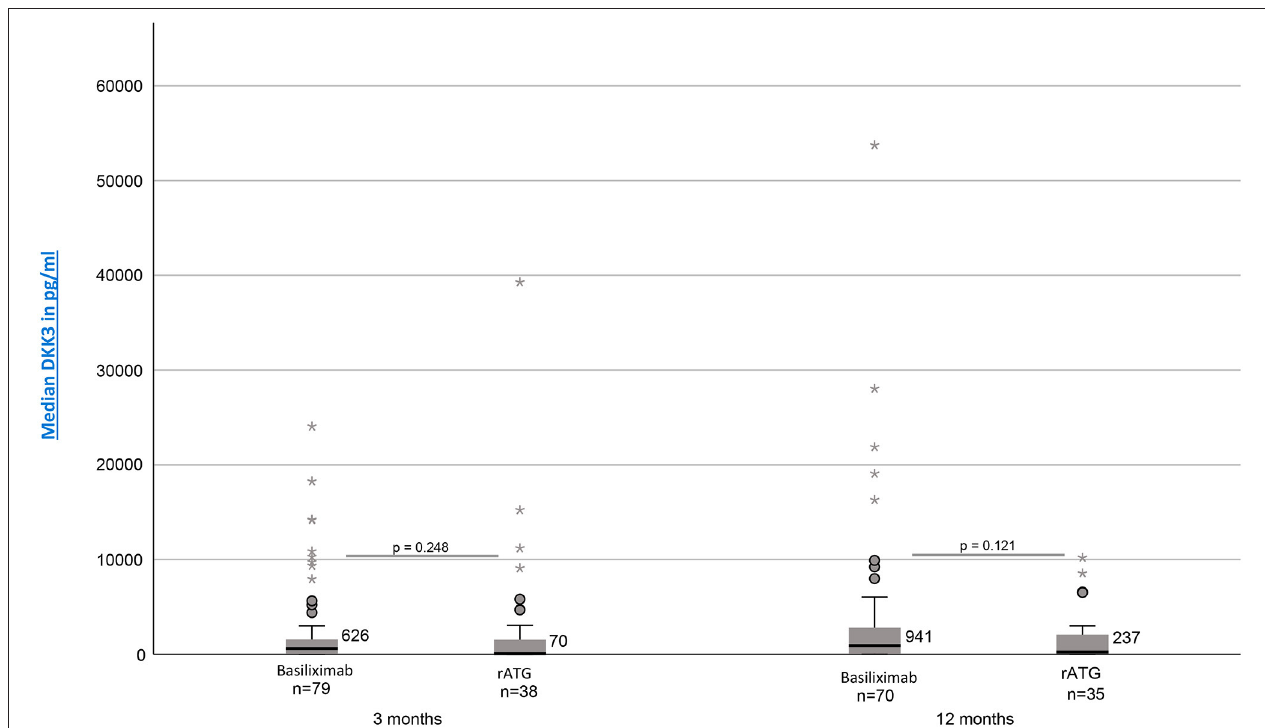
FIGURE 2 | DKK3 values at time point 3 and 12 months depending on induction therapy (Basiliximab vs.